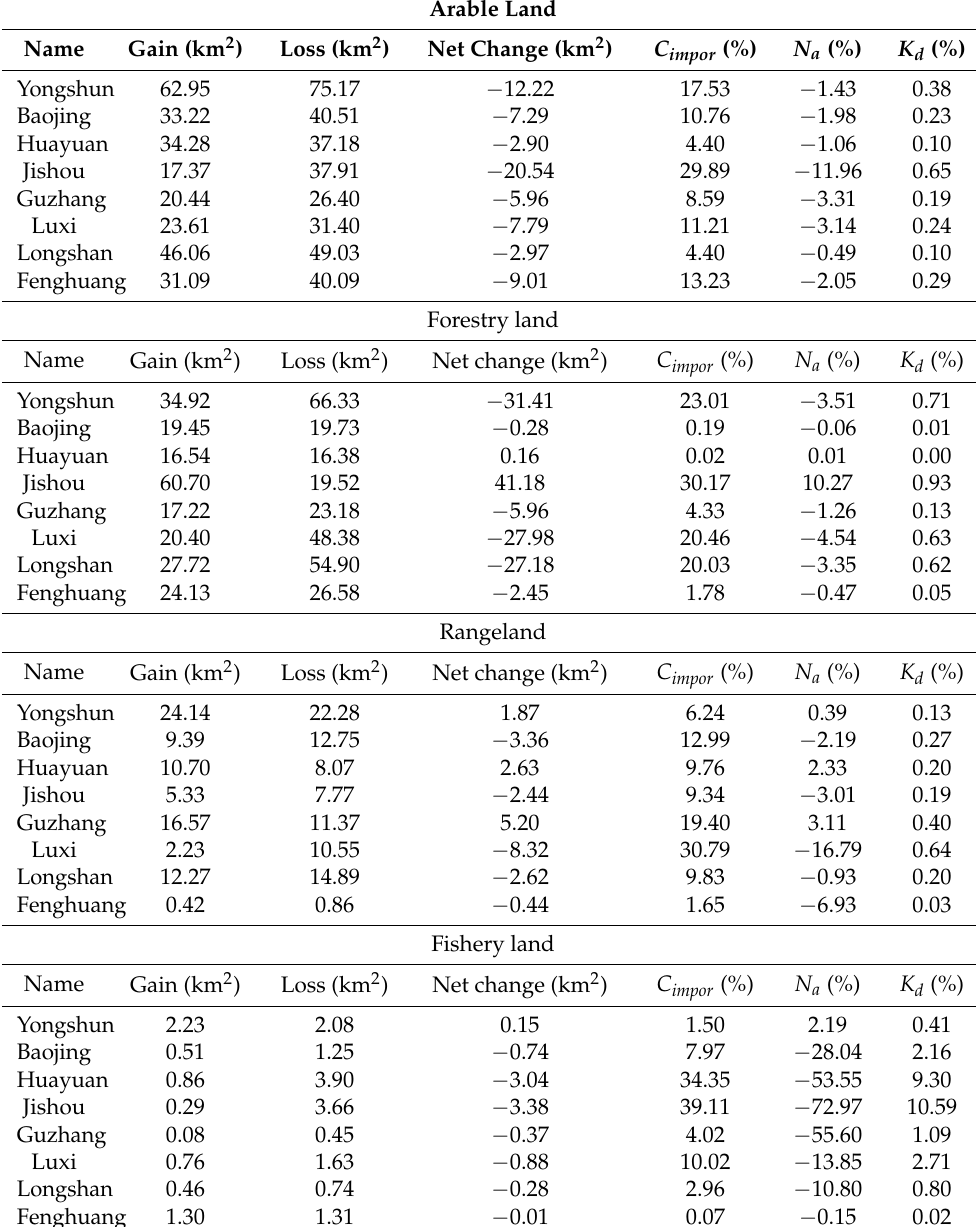
Table 5. Statistics of each agricultural land use change for